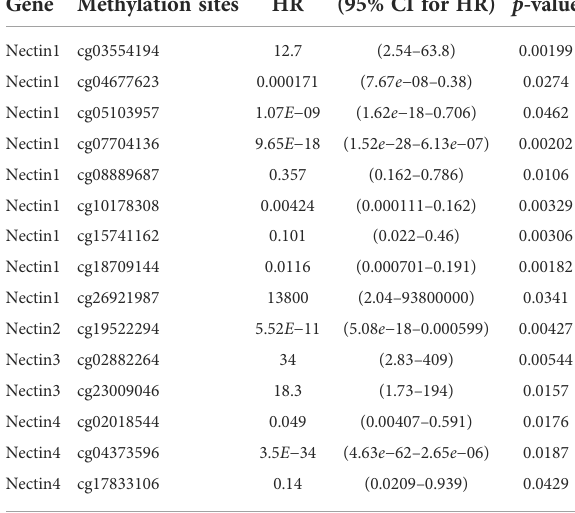
TABLE 3 Analysis of nectin-1, nectin-2, nectin-3, and nectin-4 gene methylation sites and overall survival rate of HCC patients. Gene Methylation